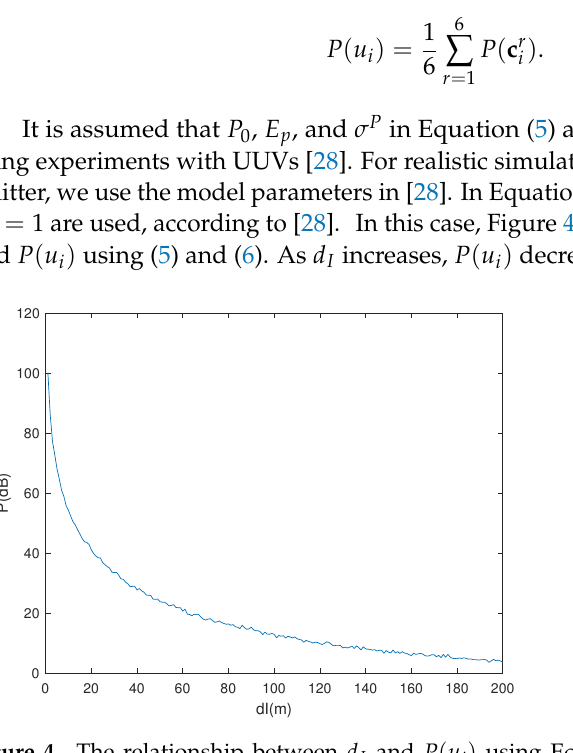
Figure 4. The relationship between d I and P ( u i ) using Equations (5) and (6). As d I increases, P ( u i )